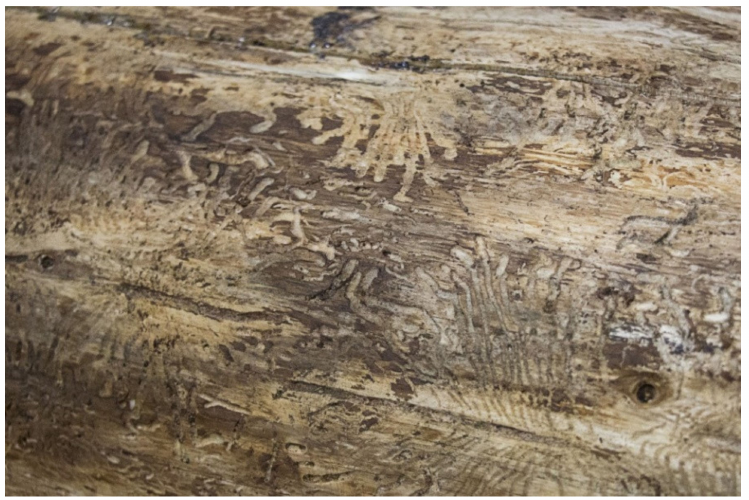
Figure 2. Mechanical damage to the xylem of a bark beetle-attacked tree by bark beetle larvae on the woodsurface of Norway spruce ( Picea abies ) (own